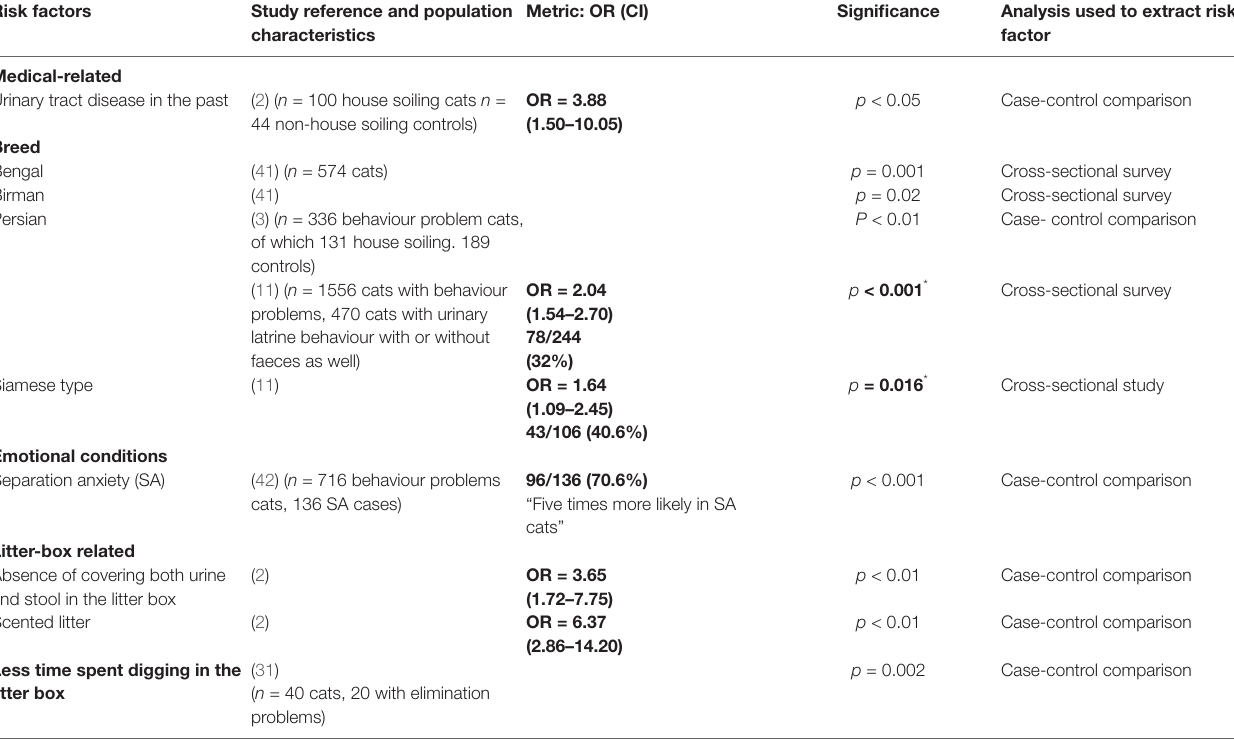
TaBle 3 | Risk factors for urinary house soiling (periuria) in the home and associated data from a review of the